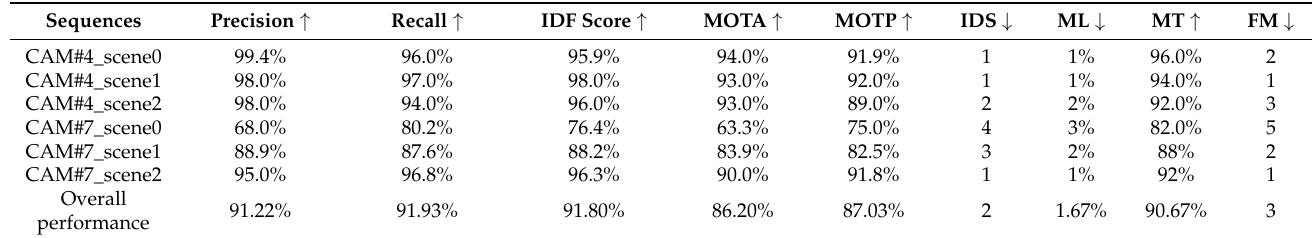
Table 2. Performance evaluation metrics on EPFL dataset campus sequence.